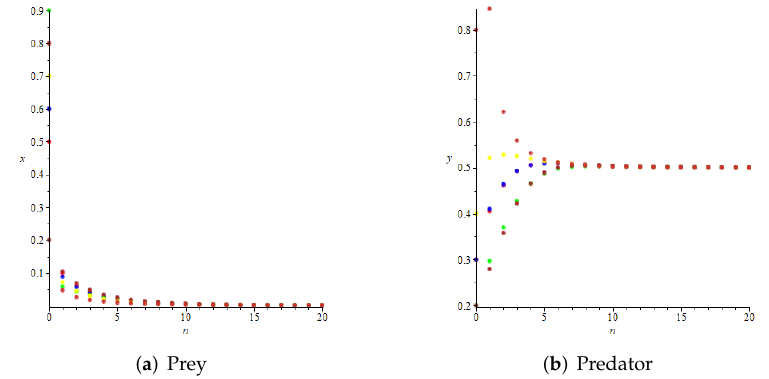
Figure 6. Global attractivity of prey-free